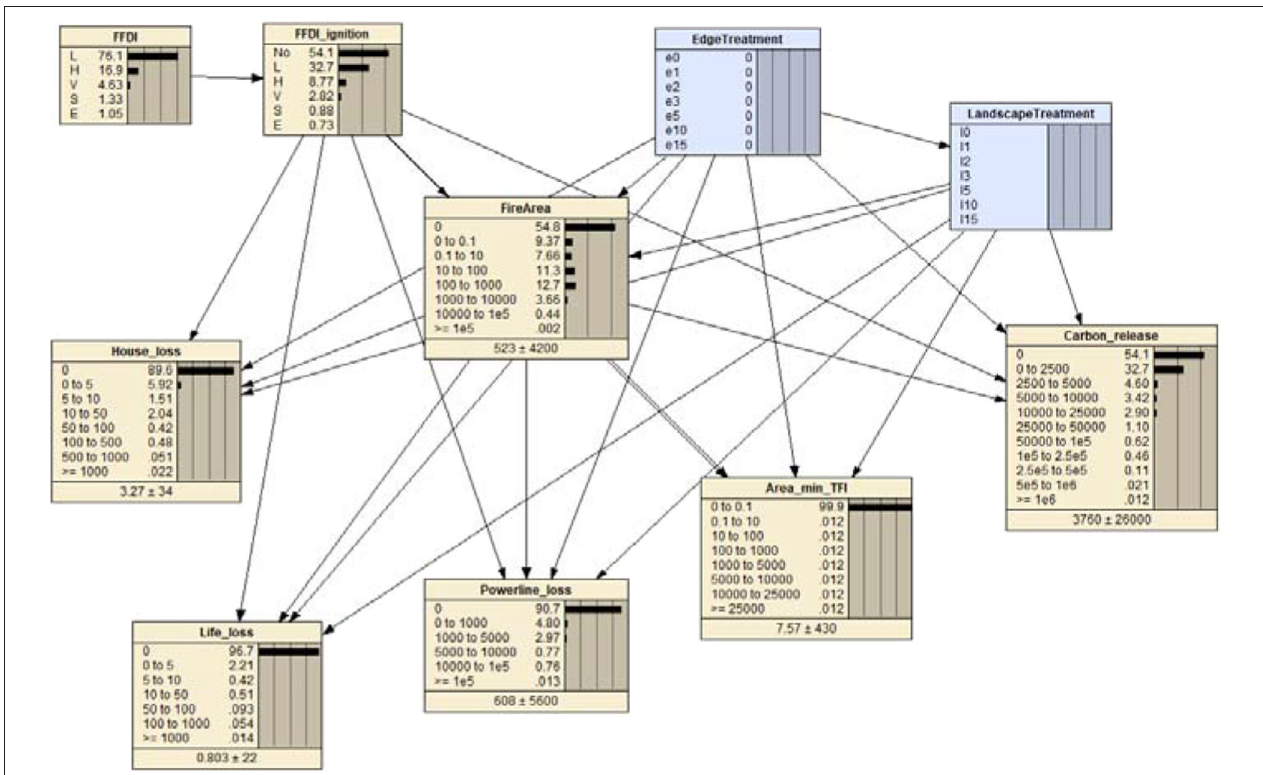
FIGURE 3 | The BDN structure (influence diagram) used in the study. Boxes represent nodes and the average distribution of values across all decisions. Bar plots represent the average distribution of values across all decisions. Numbers next to bars represent the probability of being in the given state. Values at the base of the boxes represent the expected values plus or minus one standard